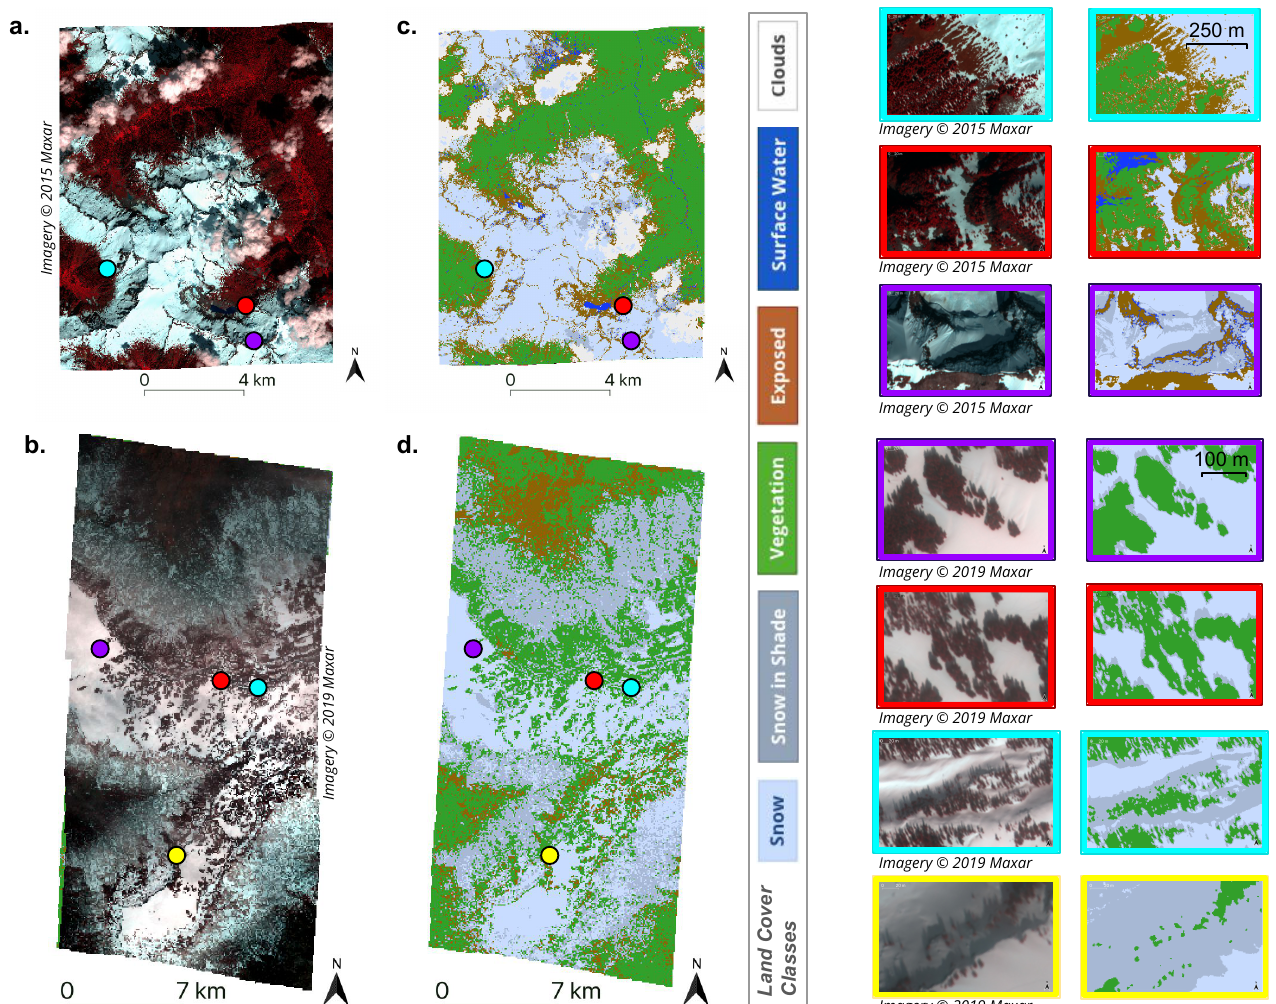
Figure 4. ( a ) Color-infrared WorldView-3 (WV-3) images acquired on 20 May 2015 over the North Cascades site and on ( b ) 26 March 2019 over the Grand Mesa site. Corresponding land cover classification maps from random forest models ( c ) M7 and ( d ) M17 (see Supplementary Table S2). Zoomed insets show detail for corresponding points in ( a – d